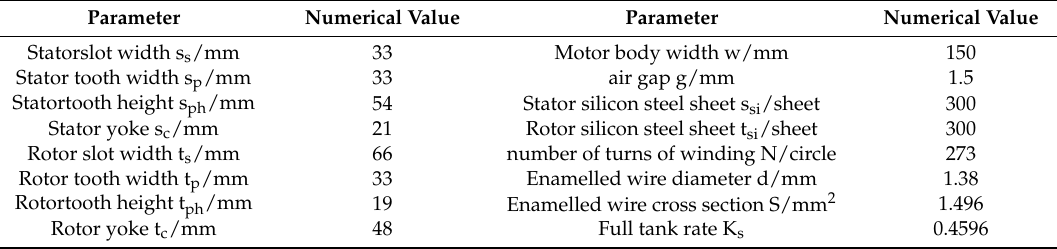
Figure 2. Schematic diagram of DLSRG. The A, B, C represents the three-phase winding. In DLSRG winding, the three phase excitation is equal, the phase difference is 0, the structural parameters of DLSRG are shown in Table 1. Table 1. DLSRG parameters.